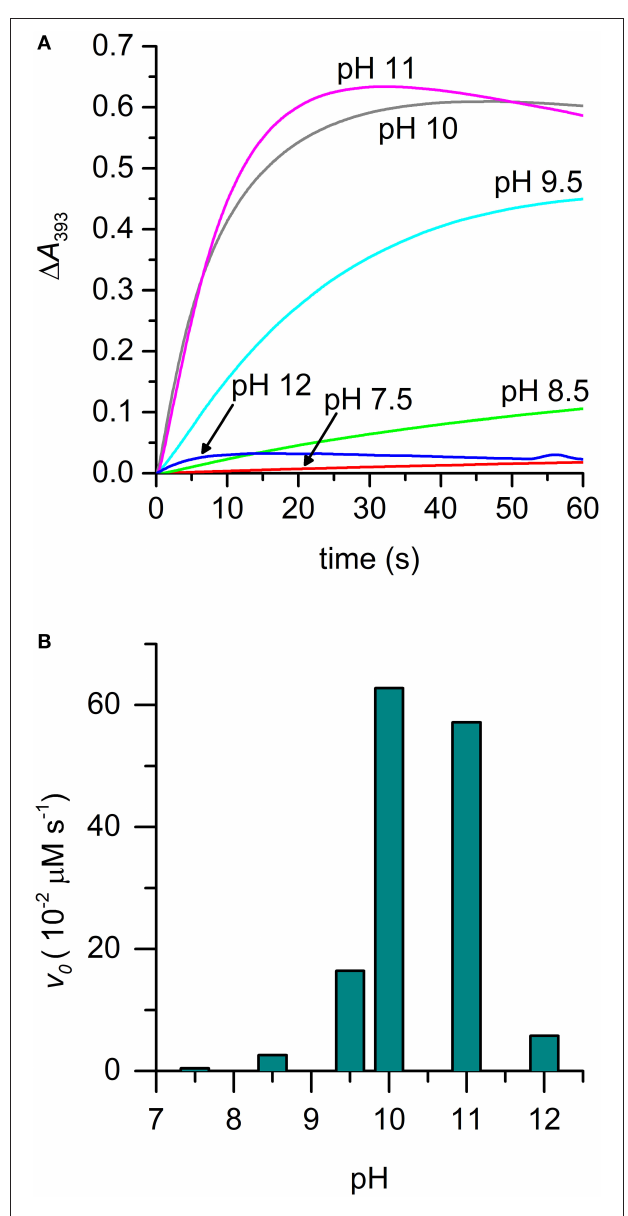
FIGURE 6 | Time-course of [Mn IV = O] ·+ formation in different pH conditions. (A) Experimental curves at different pHs are reported with different colors: pH 7.5, red; pH 8.5, green; pH 9.5, cyan; pH 10, gray; pH 11, magenta; pH 12, blue. (B) Plot of the initial rate ( v 0 ) as a function of pH. Reaction conditions : Mn-MC6*a, 20 µ M; H 2 O 2 , 20 µ M; T = 25 ◦ C. Various buffers were used depending on the pH, as described in the experimental